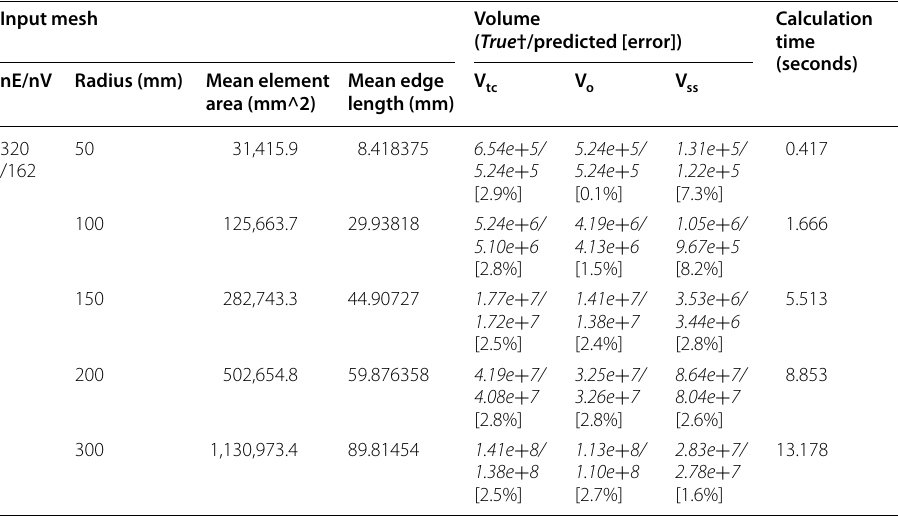
Table 2 Volume error estimation for